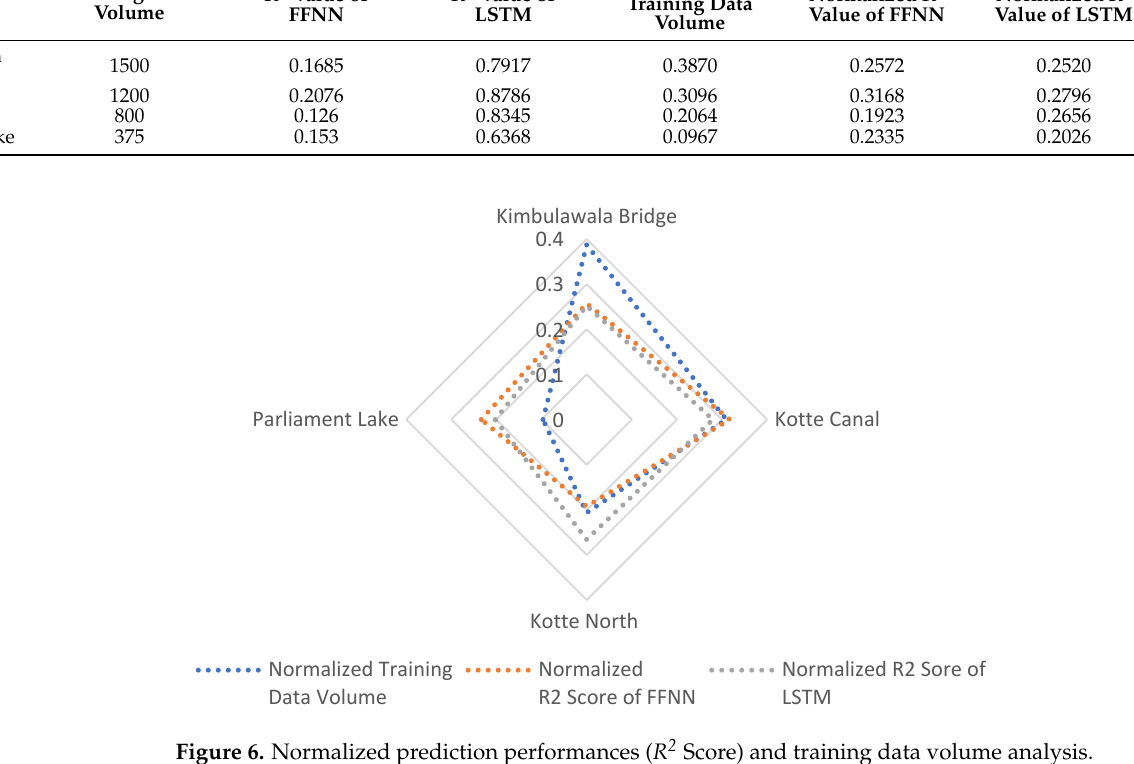
Figure 6. Normalized prediction performances ( R 2 Score) and training data volume analysis.